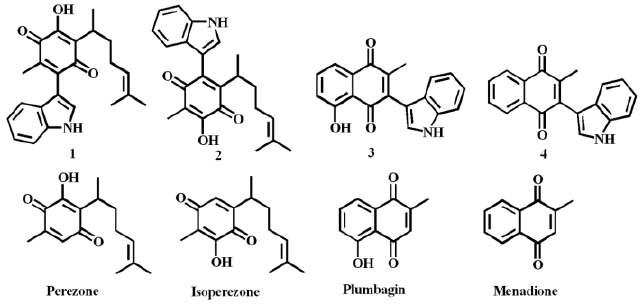
Figure1. Target molecules, and their corresponding quinone raw material. Figure 1. Target molecules, and their corresponding quinone raw